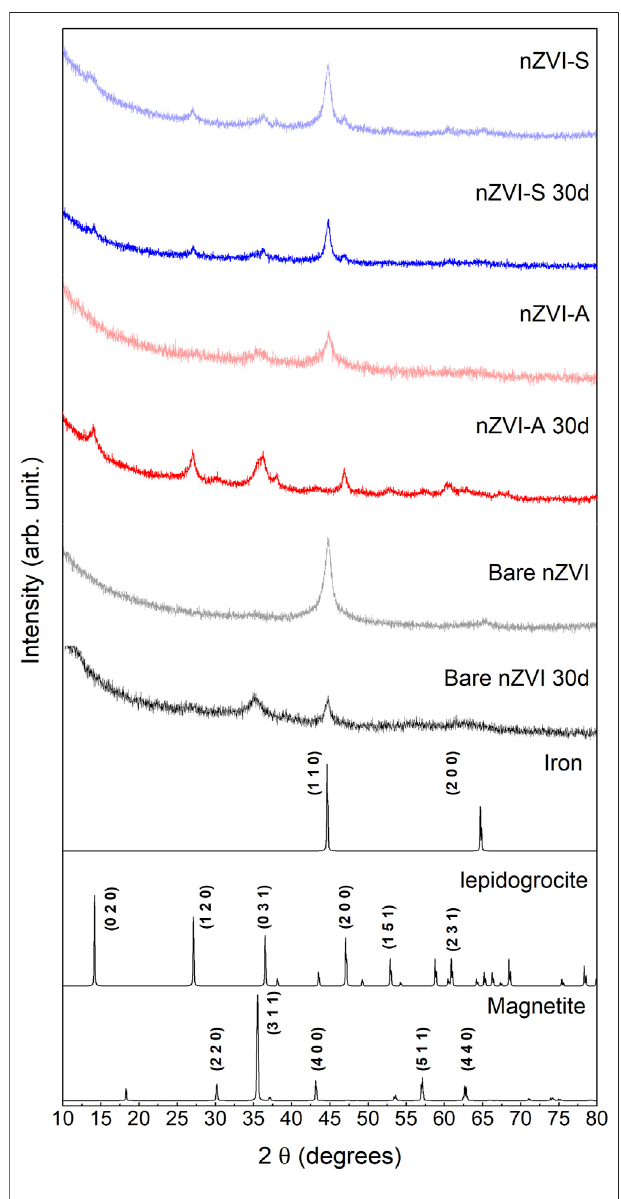
FIGURE 2 | X-ray diffraction peaks associated with nZVI particles were recorded:freshlysynthesizedsamples(lightercolour)and30-dayoldsamples (darker colour). The Pattern Diffraction File (PDF) of metallic iron (PDF 87- 7194), lepidocrocite (PDF 8-98) and, magnetite (PDF 74-419) were displayed as